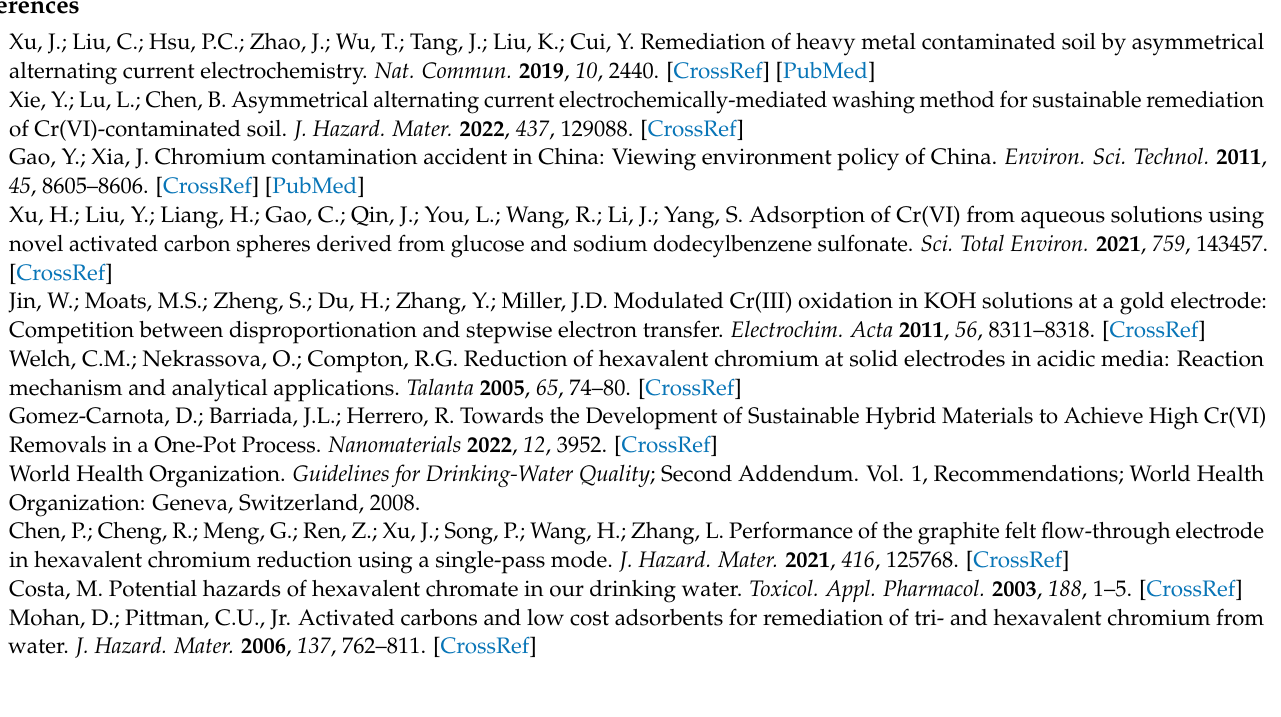
Table S2: Fitting parameters of adsorption isotherm of Cr (VI) by Ami-CF; Table S3: Adsorption capacity of adsorbents for Cr (VI); Table S4: Influence of different concentrations of Cu (II), Zn (II) and Ca (II) on distribution percentage of the Cr (VI) species from the simulation results for 100 mg/L Cr (VI) solution at pH 2 by using Visual MINTEQ 3.1. The following references were cited in Supplementary Materials: